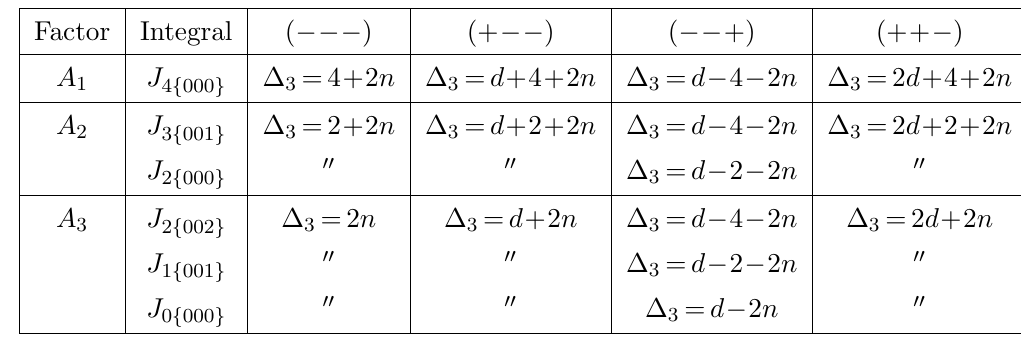
Table 7 . Singularities arising in triple- K integrals for the form factors of h T (cid:22)